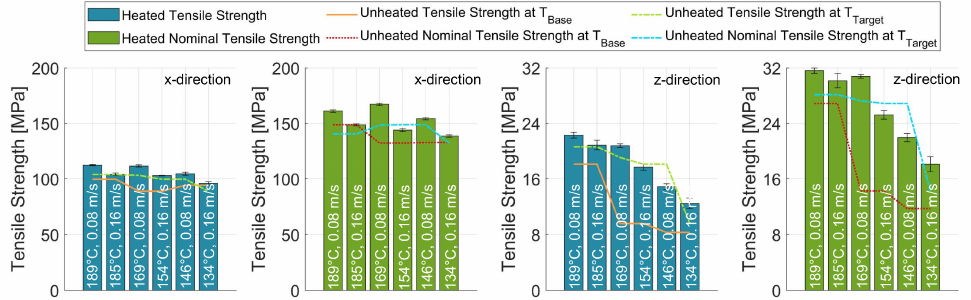
Figure 6. Standard and nominal tensile strength of the heated specimens with the reference ten- sile strengths for unheated specimens at the same base temperatures and the achieved heated